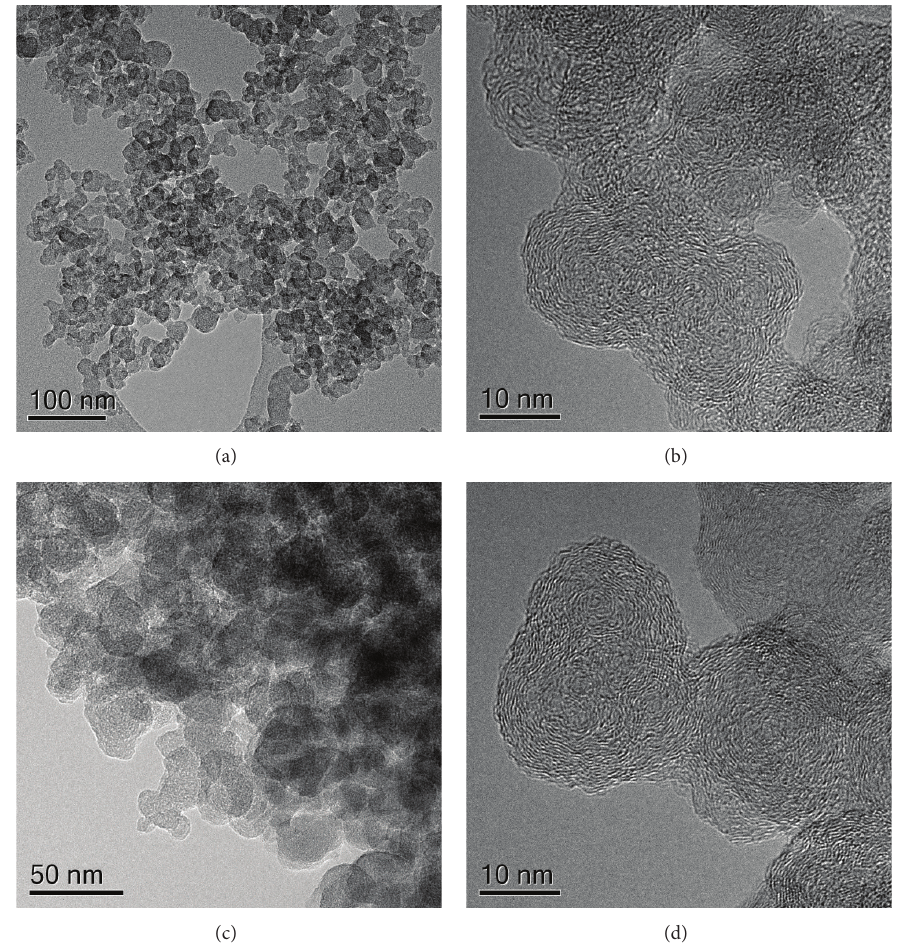
Figure 2: TEM and HRTEM images of the soot particles emitted in Euro 4 (a, b) and Euro 5 (c, d) calibration